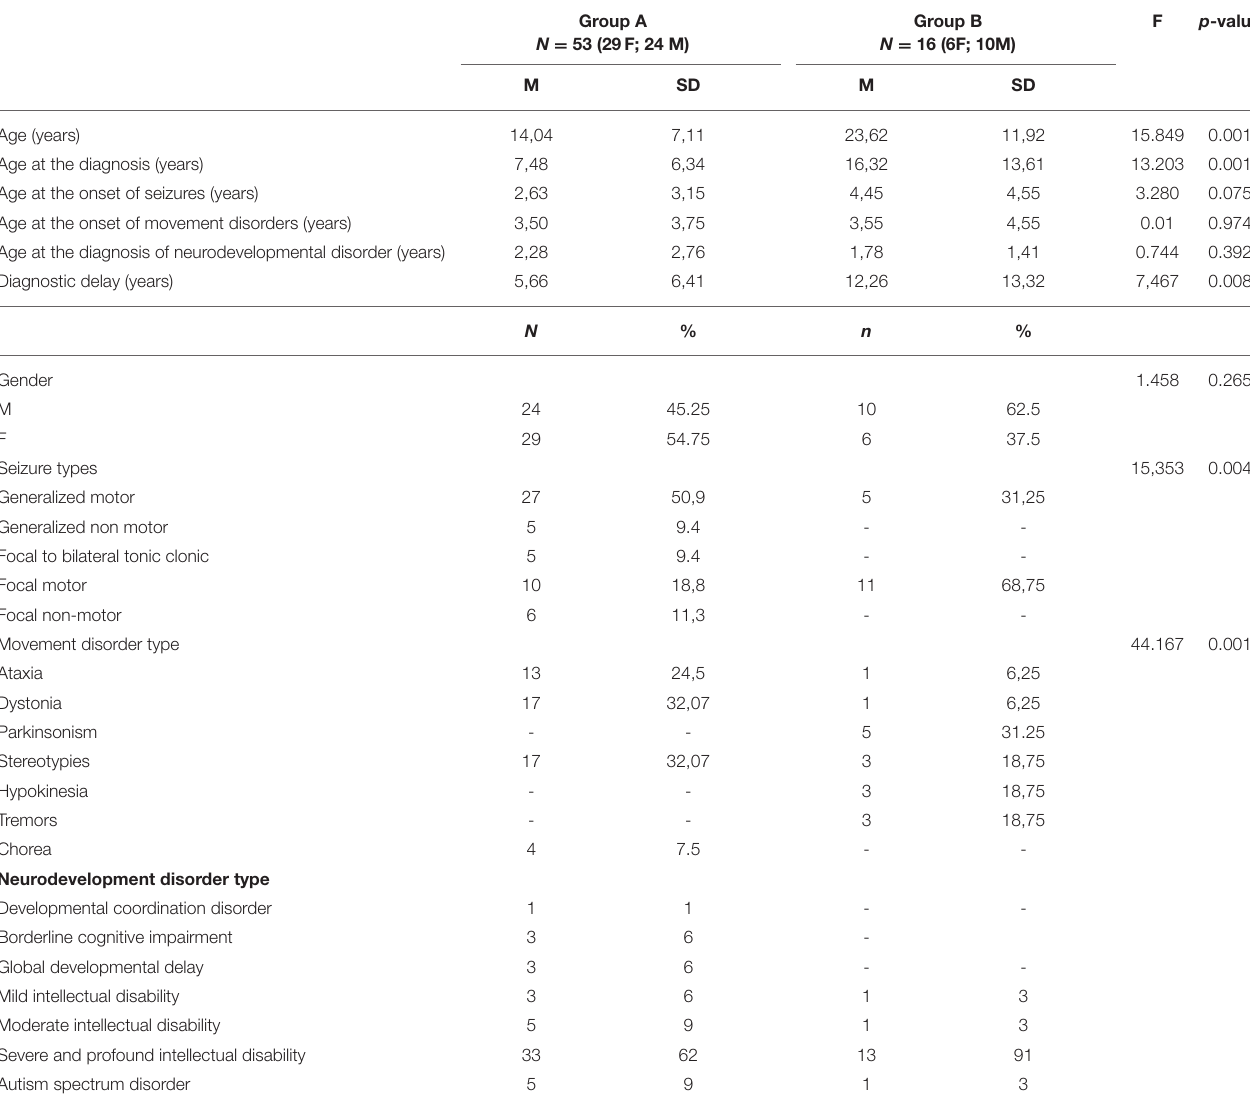
TABLE 3 | Differences between groups in continuous and discrete